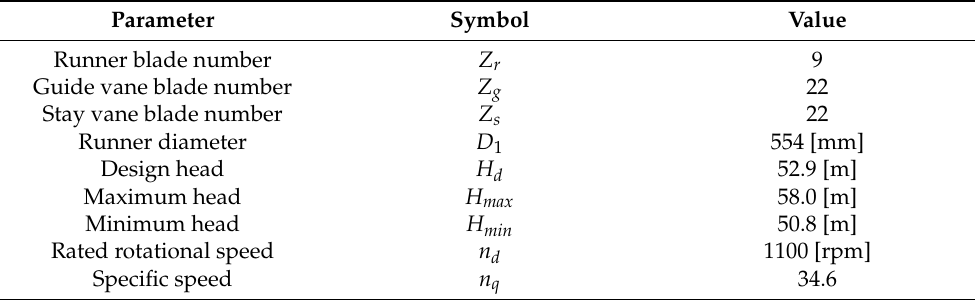
Figure 1. The 3D model of the fluid domain of the reversible pump turbine’s hydraulic components. Table 1. Main parameter of reversible pump turbine unit.